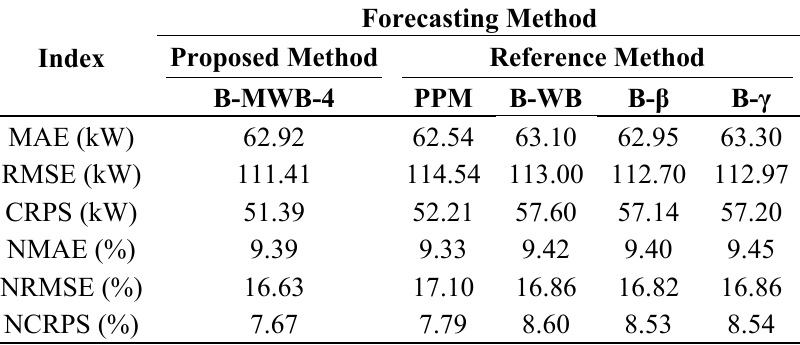
Table 7. Time-series TS4: Values of absolute and percentage indices for the forecasts averaged from 1 October 2013 to 31 October